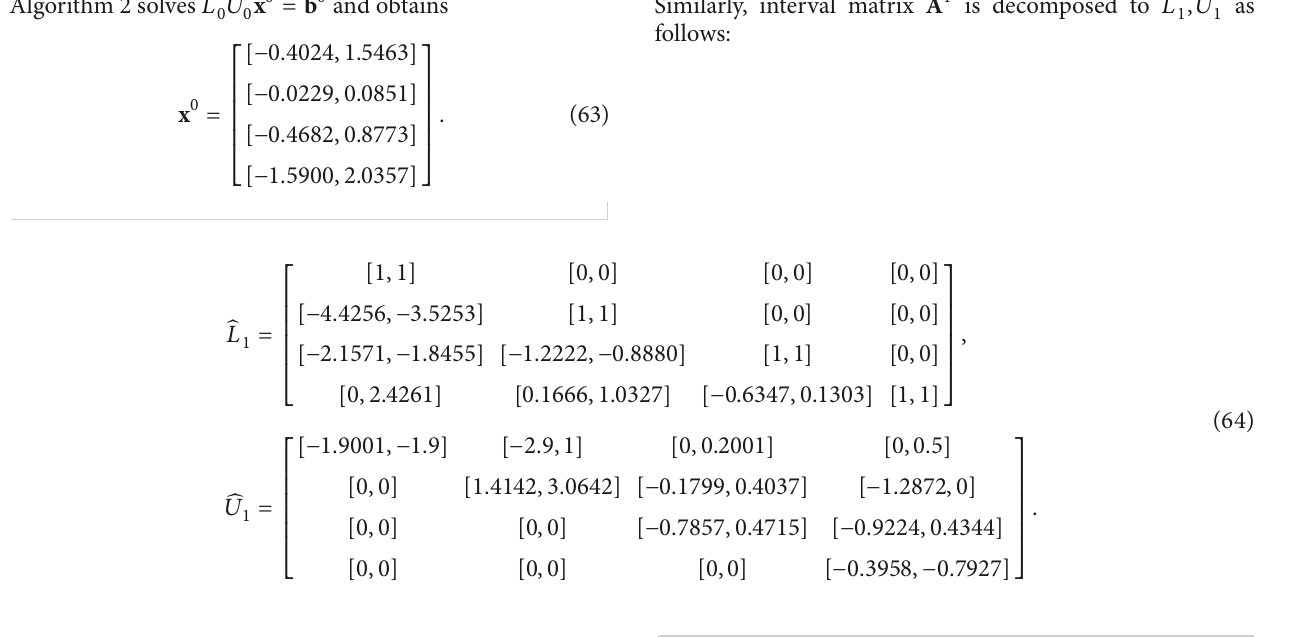
Algorithm 2 solves